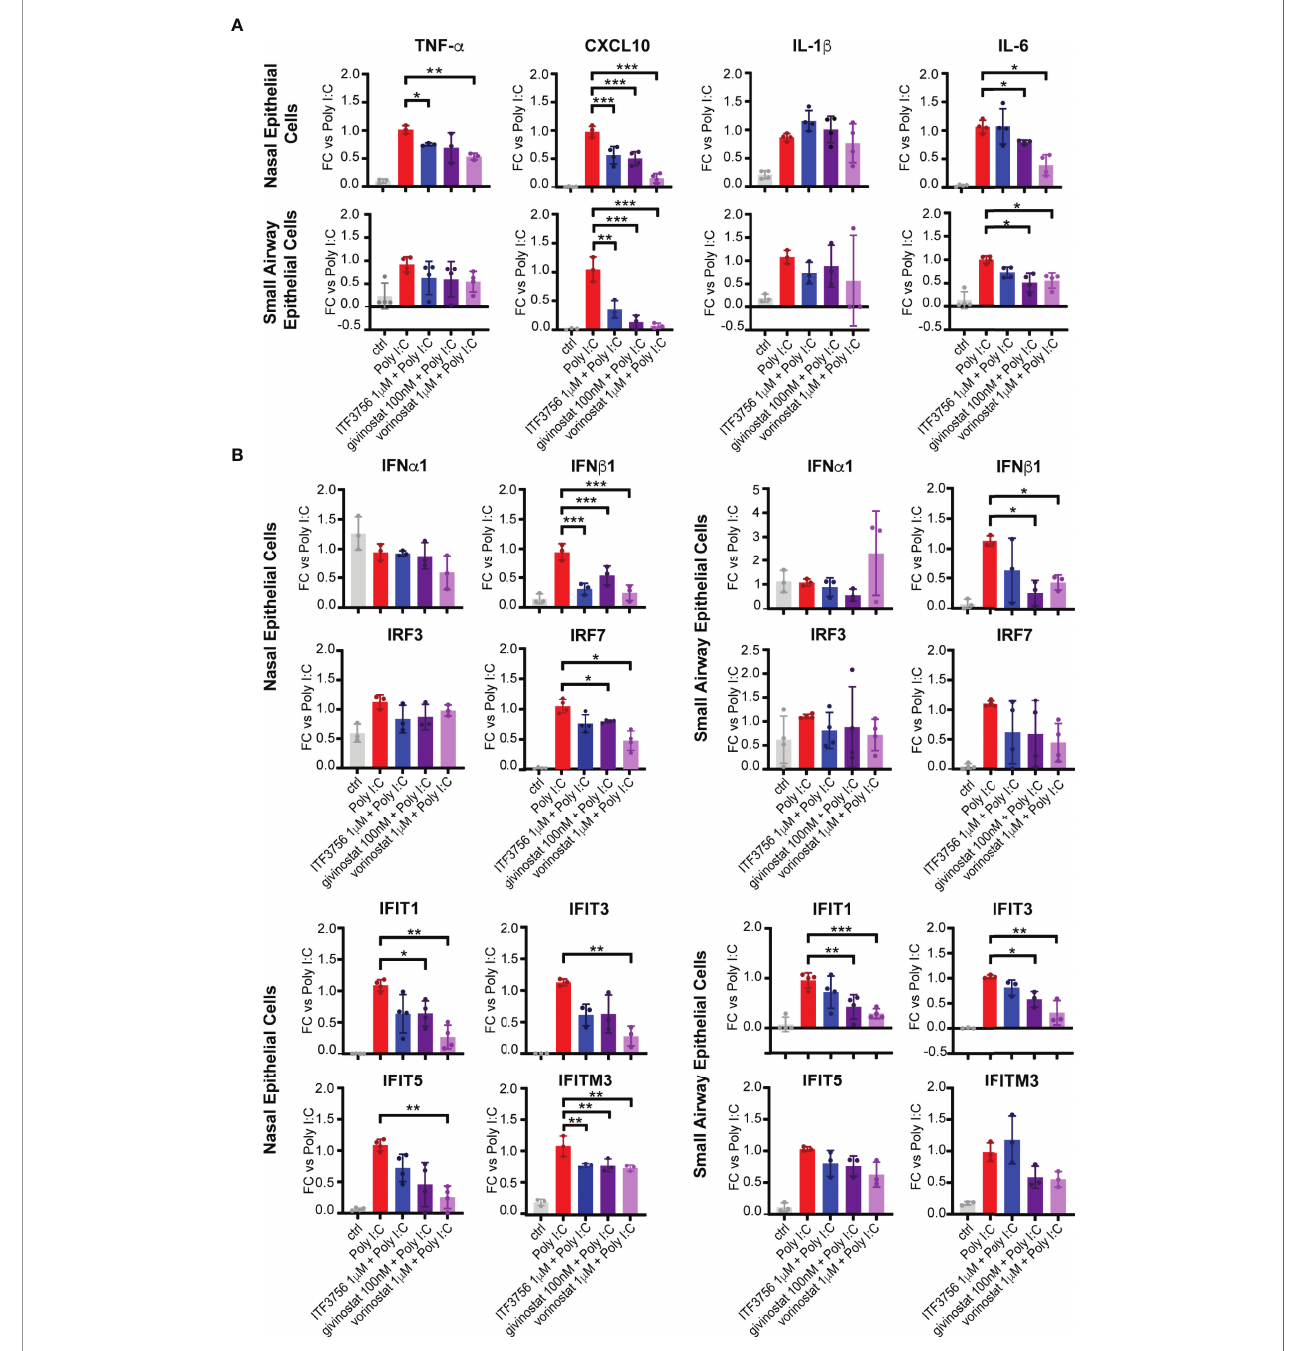
FIGURE 1 | HDACi treatment downmodulates the expression of pro-in fl ammatory cytokines and IFN pathway genes in epithelial cells of the upper and lower respiratory tracts. Nasal epithelium primary cells (HNEpC) and lung epithelium primary cells (SAEpC) were pre-treated with ITF3756, givinostat and vorinostat for 2 hours and then stimulated with Poly I: C 10 m g/ml for 18h. The expression of pro-in fl ammatory cytokines (A) and IFN pathway genes (B) was subsequently analyzed by qPCR. The graphs show the mean± SD of 3 or more biological replicates. FC = Fold changes. P values were calculated by RM one-way ANOVA as described in material and methods. *P < 0.05, ** < 0.01, *** <